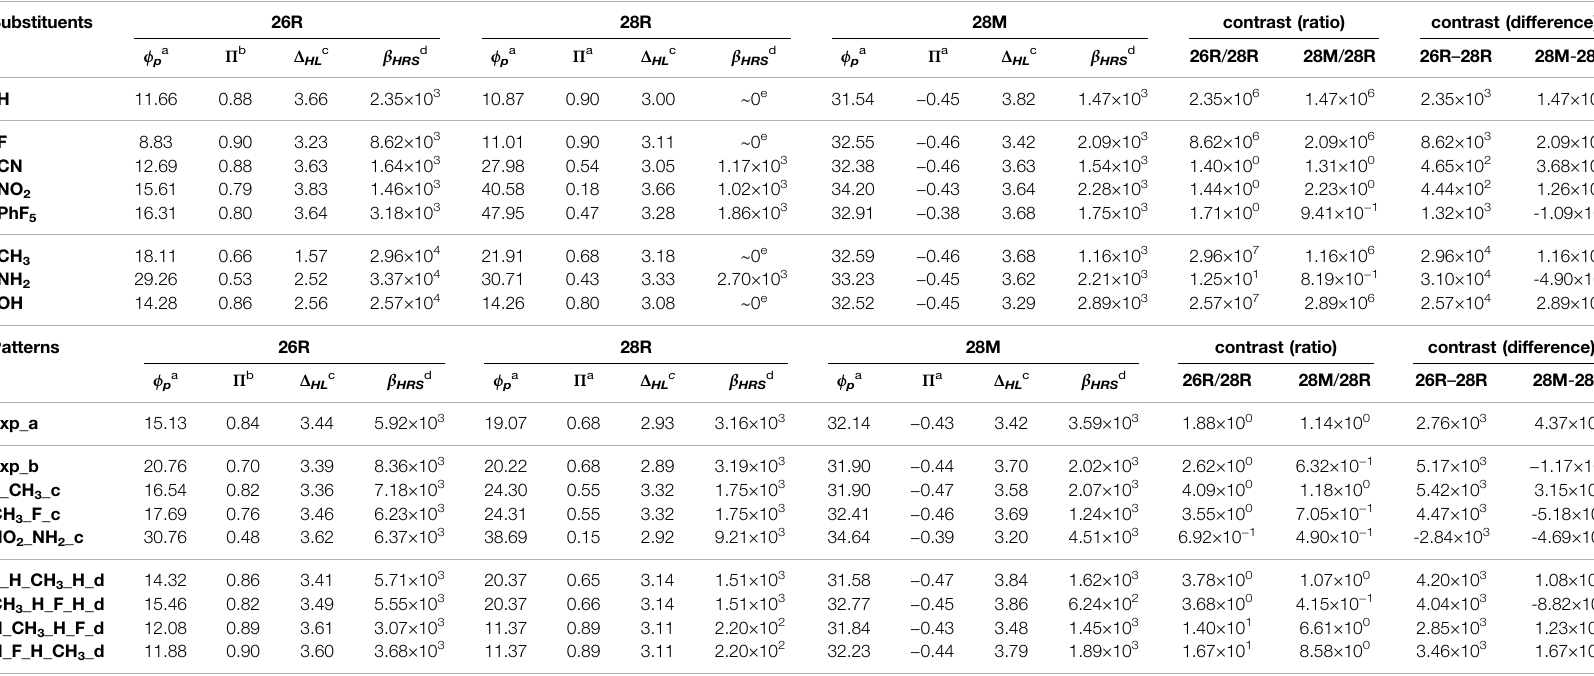
TABLE 2 | Most relevant structural, energetic and optical properties of the meso -substituted hexaphyrins. Substituents